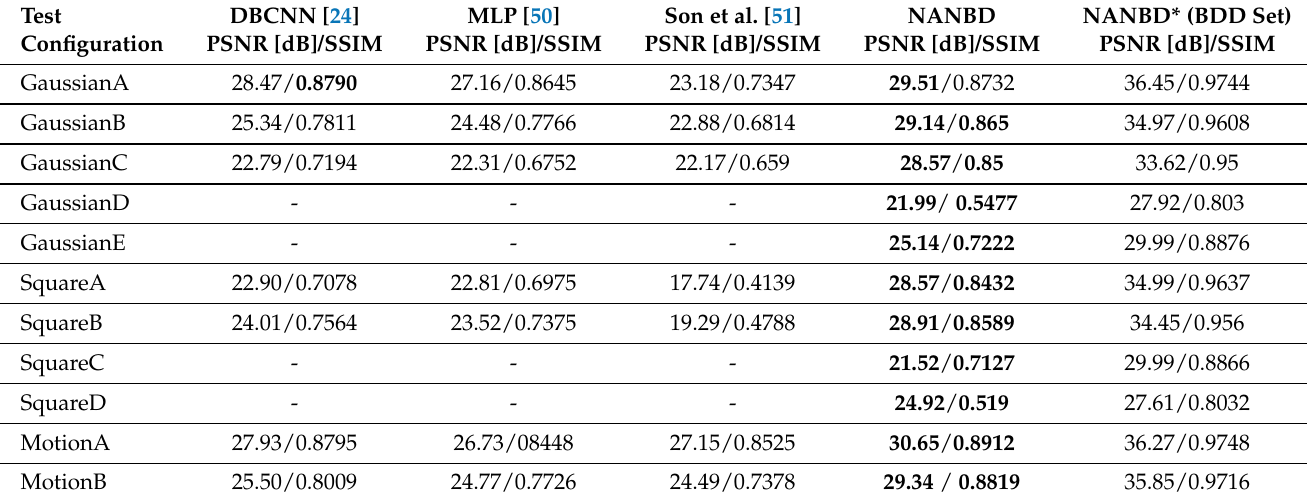
Table 4. Comparison of the proposed method (NANBD) to state-of-the-art approaches. Best values are marked in